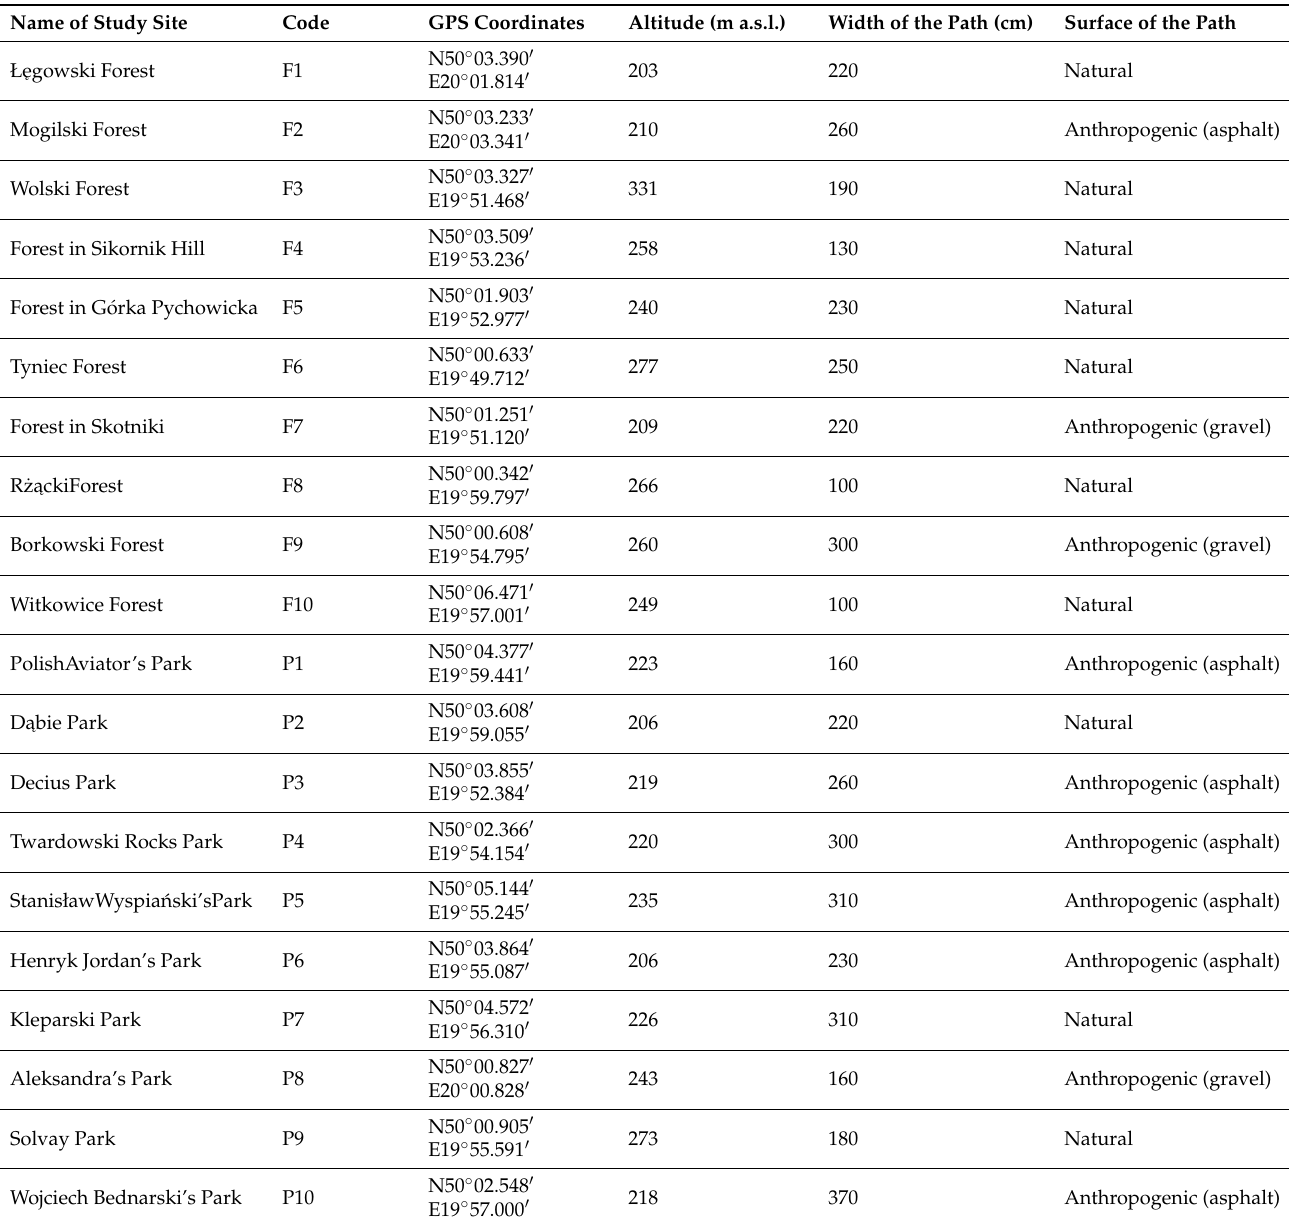
Table 1. Characteristics of study